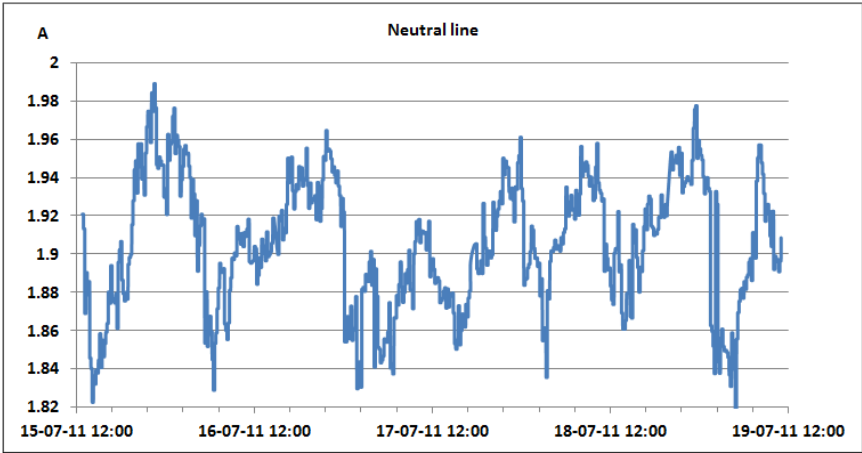
Figure 22. TRMS values of 3rd electric current harmonic measured on the neutral